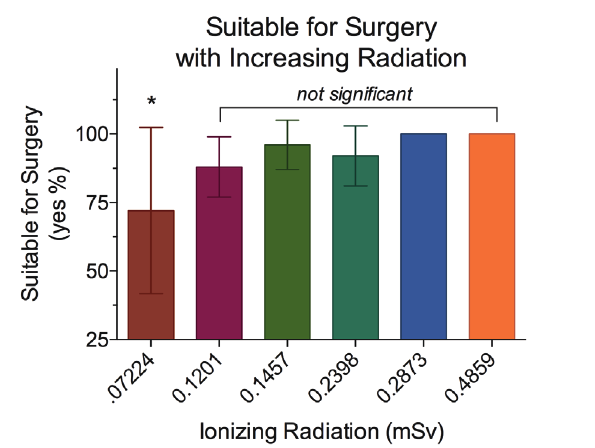
Figure 4. At the highest two radiation levels, the evaluators unanimously determined the scans were suitable for surgery. The scan obtained at 0.07224 mSv (100 kV, 30 mA) was significantly inferior to the scans obtained at 0.4859 (120 kV, 120 mA). The intermediate scans were statis- tically equivalent to the 0.4859 (120 kV, 120 mA)